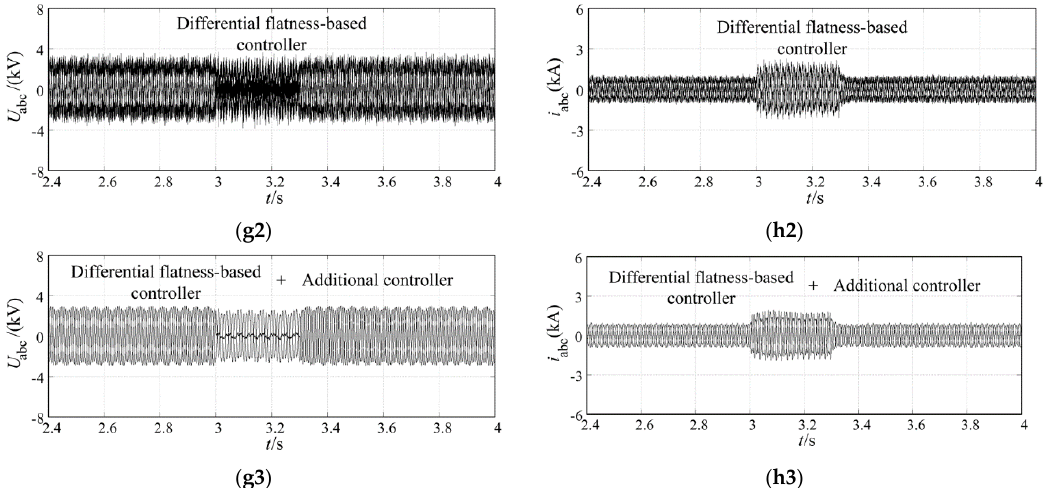
Figure 9. Simulation results of phase-to-phase grid fault condition. ( a1 – a3 ) DC voltage; ( b1 – b3 ) Second harmonic components of DC voltage; ( c1 – c3 ) Grid-side active power; ( d1 – d3 ) Second harmonic components of grid-side active power; ( e1 – e3 ) Grid-side reactive power; ( f1 – f3 ) Second harmonic components of grid-side reactive power; ( g1 – g3 ) Voltage at the low-voltage side of the transformer during grid short-circuit fault; ( h1 – h3 ) Current at the low-voltage side of the transformer during grid short-circuit fault.